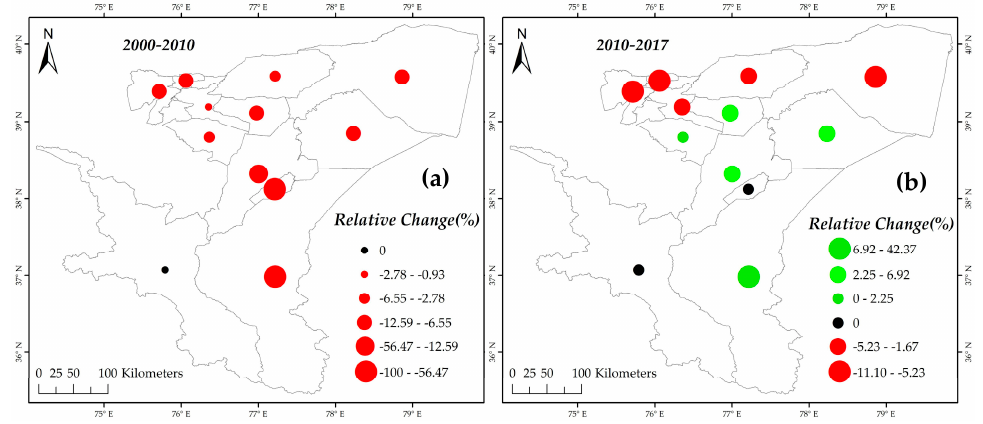
Figure 5. Relative change rate of salinized soil area in different counties of the Kashgar region during 2000 to 2010 ( a ) and 2010 to 2017 ( b ).